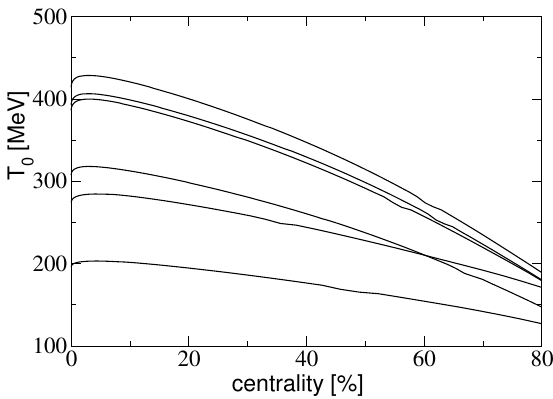
Figure 1 . Centrality dependence of the initial fireball temperature at τ 0 = 0 . 5 fm for the ideal gas model obtained in the Glauber model via the average entropy density for (from top to bottom at low centrality): 5 . 02 and 2 . 76 TeV Pb+Pb, 5 . 44 TeV Xe+Xe, 0 . 2 TeV Au+Au, 7 and 0 . 2 TeV O+O